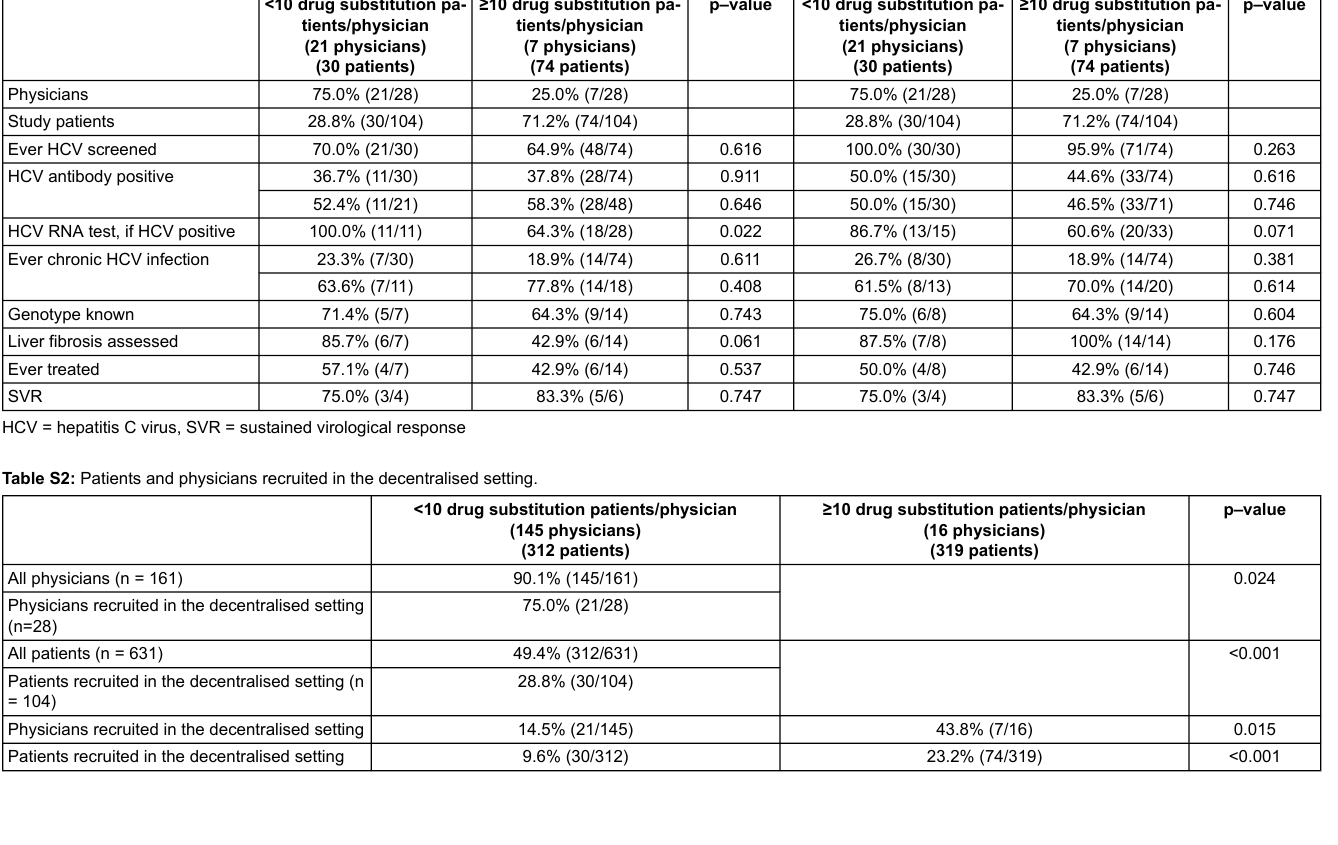
Figure S1: Patients currently HCV RNA positive, i.e., still in need of treatment: current state of evaluation and fulfilment of criteria for reim- bursement of interferon-free direct-acting antivirals treatment in Switzerland.HCV = hepatitis C virus; IDU = intravenous drug use; HIV =